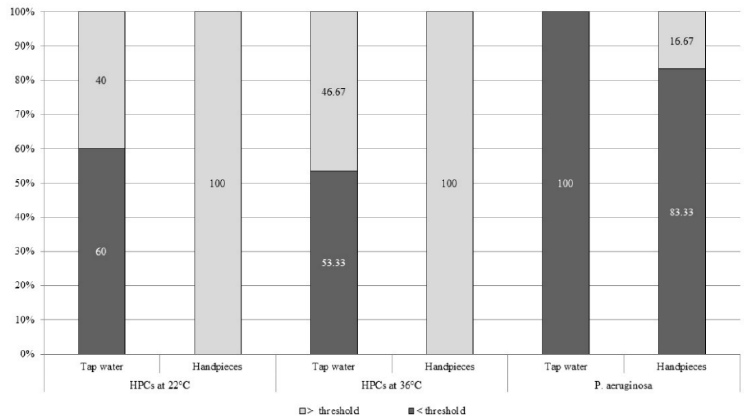
Figure 1. Percentage distribution of samples above and below target values for HPCs at 22 °C (100 CFU/mL or less), HPCs at 36 °C (10 CFU/mL or less), and P. aeruginosa (<1 CFU/100 mL) in tap water and hand-piece water.